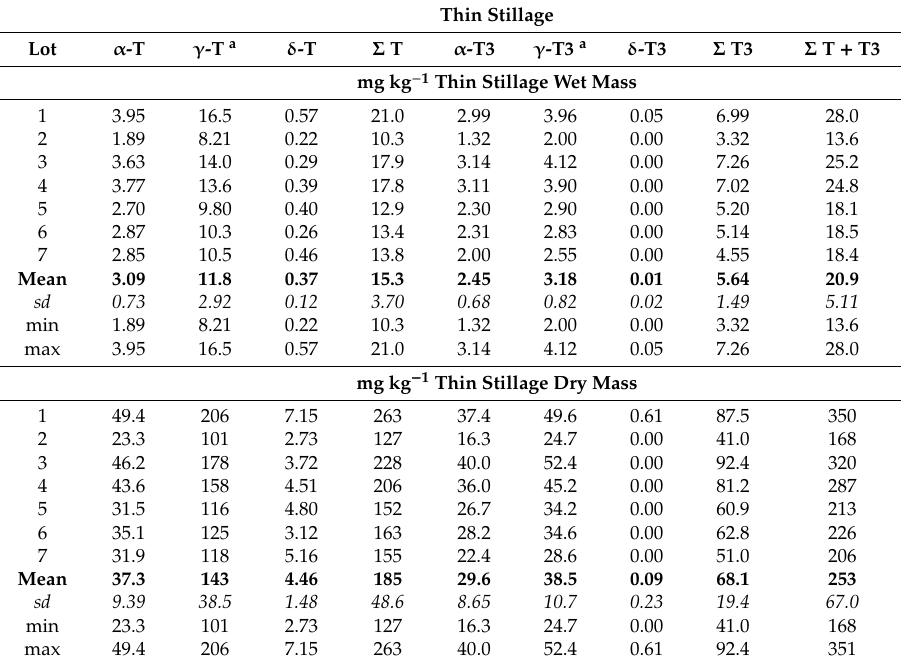
Table 4. Total amounts of tocopherols (T) and tocotrienols (T3) in thin stillage from a dry-grind corn ethanol plant. Data refer to individual lots collected at monthly intervals from July 2018 to April 2019 and overall mean, standard deviation ( sd ), and range of values observed ( n = 7)